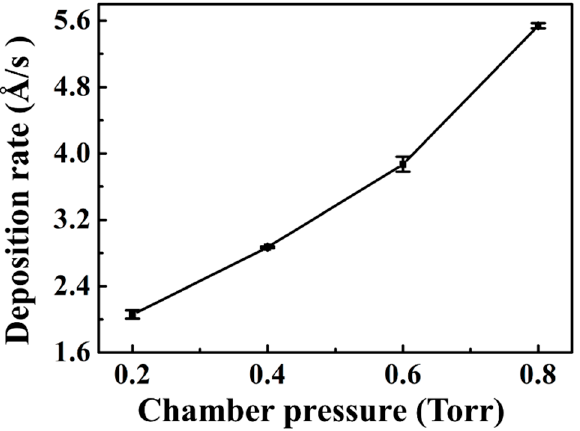
Figure 5. The deposition rate of the thin film as a function of chamber pressures of 0.2 to 0.8 Torr, with a power density of 40 mW/cm 2 , a substrate temperature of 150 °C, and a H 2 /SiH 4 flow of 50 sccm for all cases.